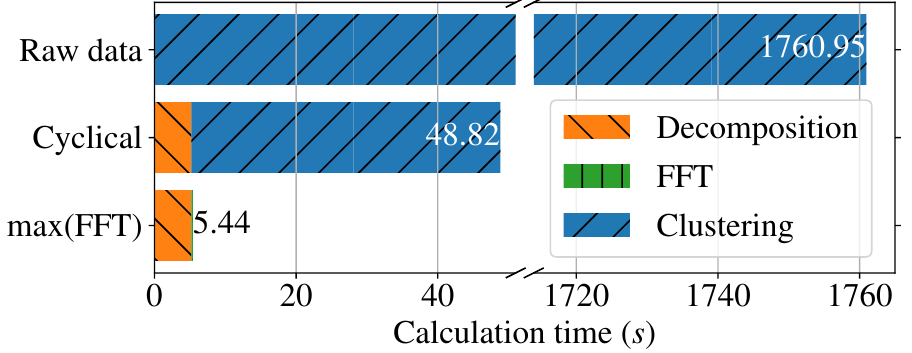
Figure 29. Calculation time on different